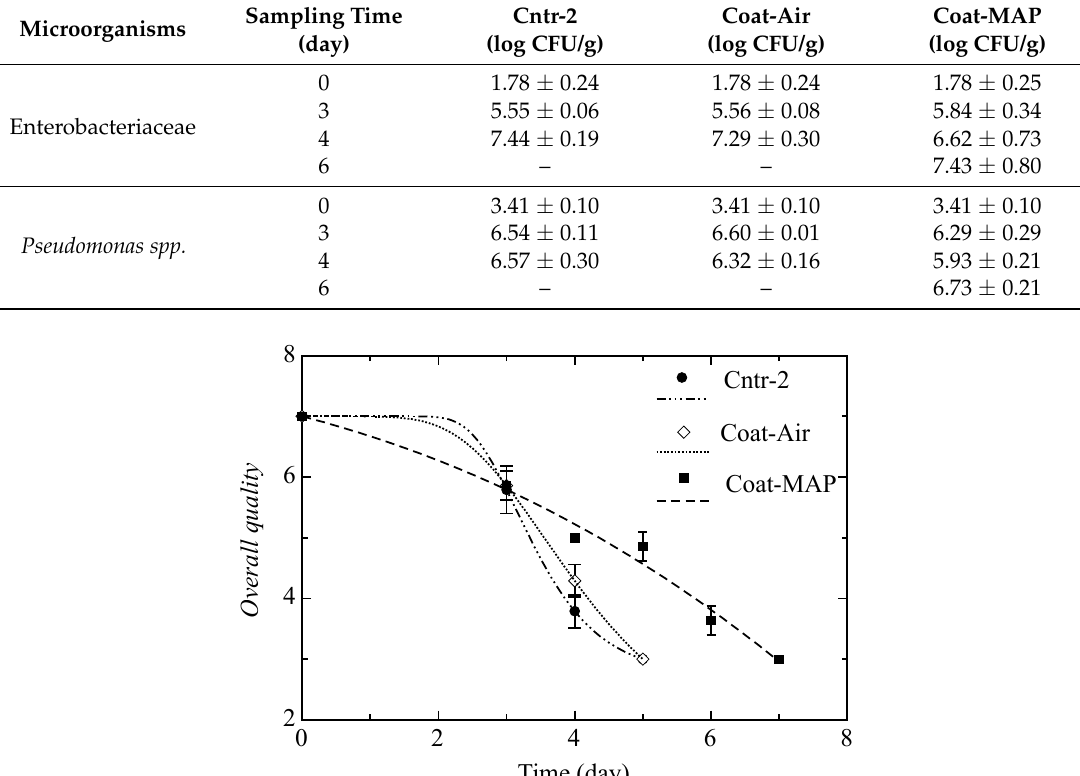
Coatings 2017 , 7 , 97 Table 3. Log CFU/g ± sd of Enterobacteriaceae and Pseudomonas spp . for Step 2 burrata samples. (Cntr-2: burrata packaged in air; Coat-Air: burrata coated with aginic acid and packaged in air; Coat-MAP: burrata coated with aginic acid and packaged under 65:35 CO 2 :N 2 ). Microorganisms